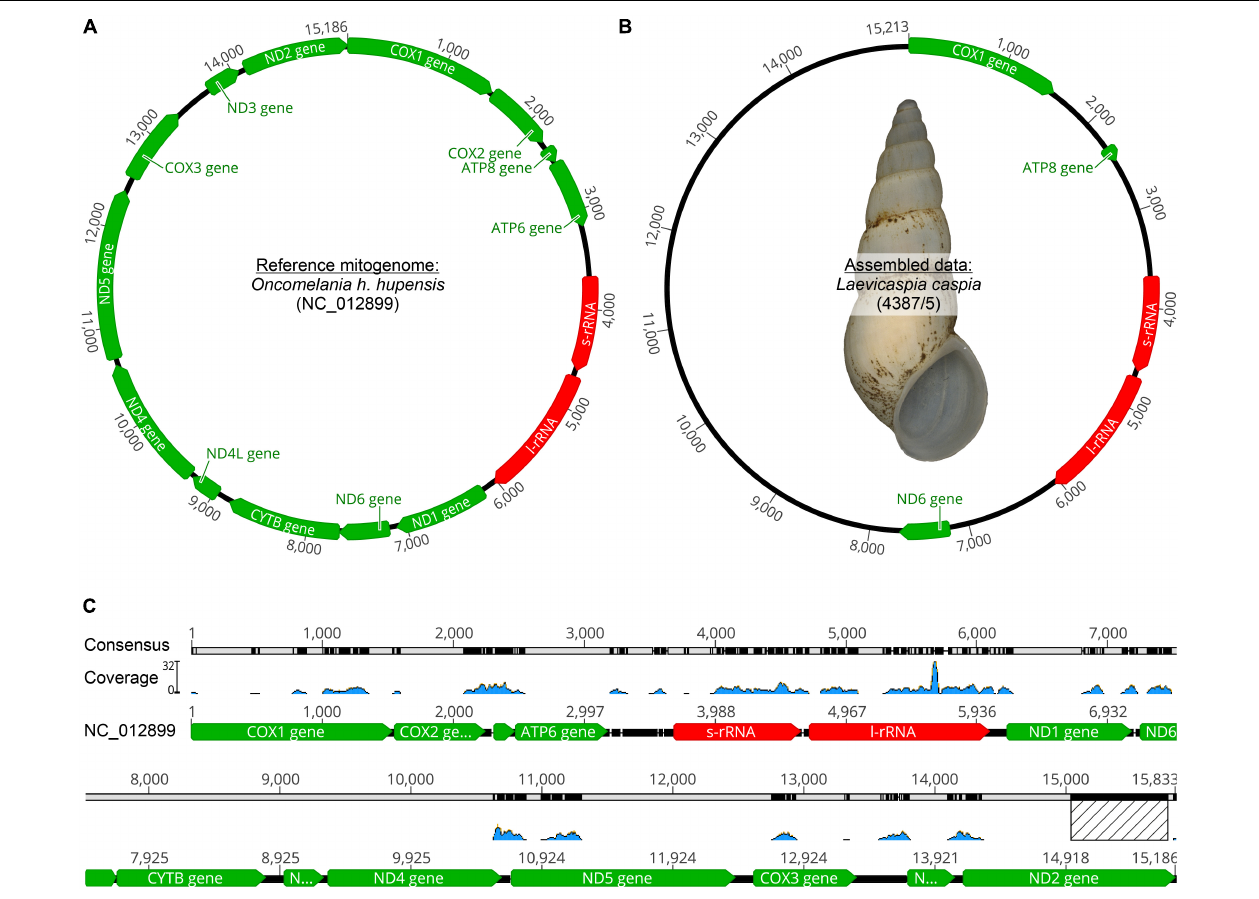
FIGURE 2 | Mitogenome mapping using Geneious Prime (version 2021.1.1). (A) Seed reference mitogenome ( O. h. hupensis : GenBank acc. no. NC_012899) where the highest coverage could be achieved, (B) Assembled data for Laevicaspia caspia (10,548 out of 6,036,414 reads; maximum coverage = 5,109; mean coverage = 157.4, see also Table 1 ) including a shell image of the sequenced individual (shell height = c. 12.4 mm), (C) Illustration of mitogenome coverage. Note that the overrepresented 778 bp fragment of ND2 (marked with a hatched rectangle) has been removed (see text for